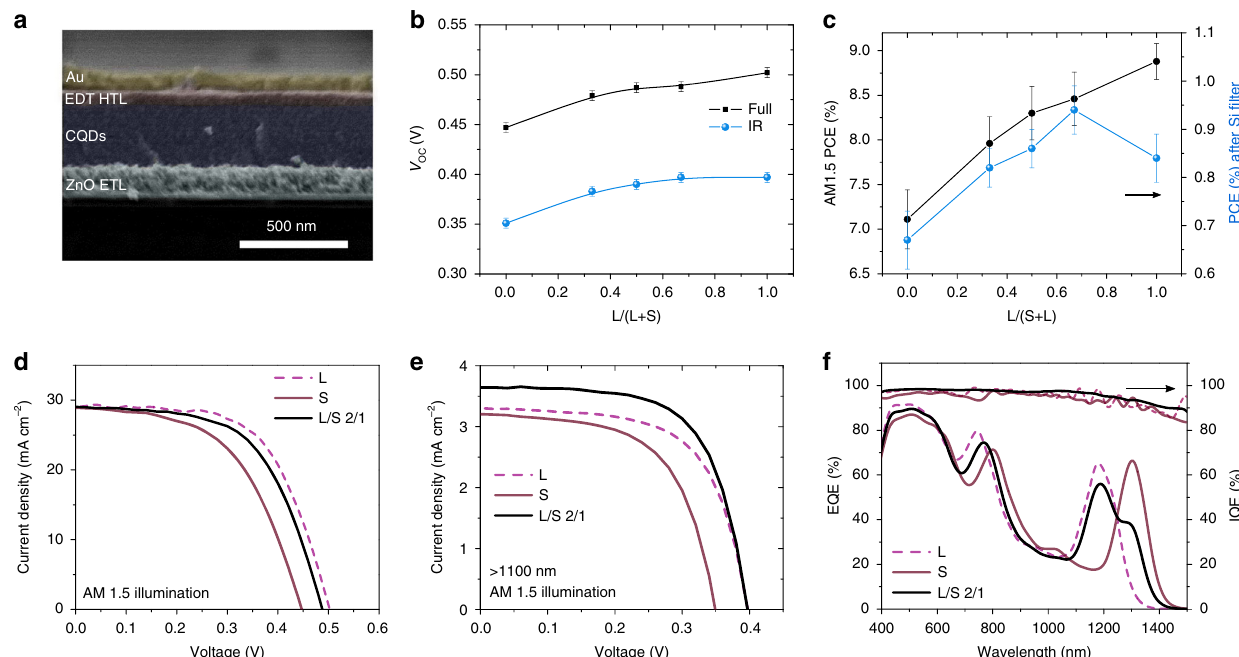
Fig. 4 PV Device architecture and performance. a Device architecture and cross-sectional SEM image of the best mixed CQD fi lm solar cell. Measured ( b ) V OC and c PCE with different inclusions of large bandgap CQDs. d J-V characteristics under AM1.5 G, e J-V characteristics after 1100 nm; f EQE curves and IQE curves of optimal single and mixed CQD solar cell